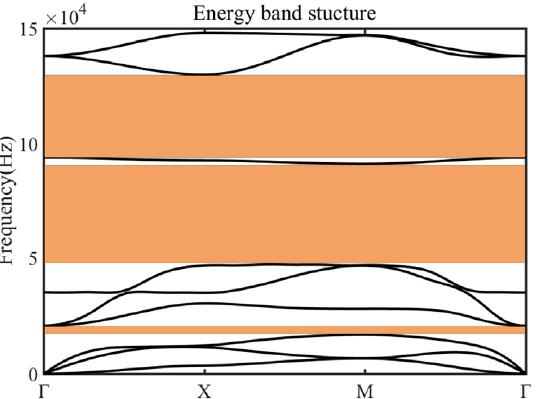
Figure 6. The schematic diagram of the energy band structure for the 6.5 mm unit cell. The parameters used are as follows: a = 6.5 mm, h 1 = 1 mm, h 2 = 4 mm, b 1 = 2.5 mm, L 1 = 2.6 mm, L 2 = 2 mm, b 2 = 0.6 mm.